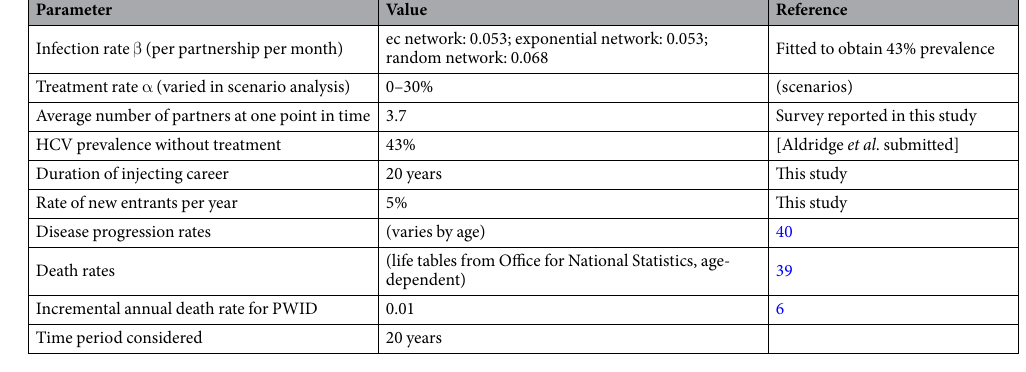
Table 2. Demographic and natural history parameter